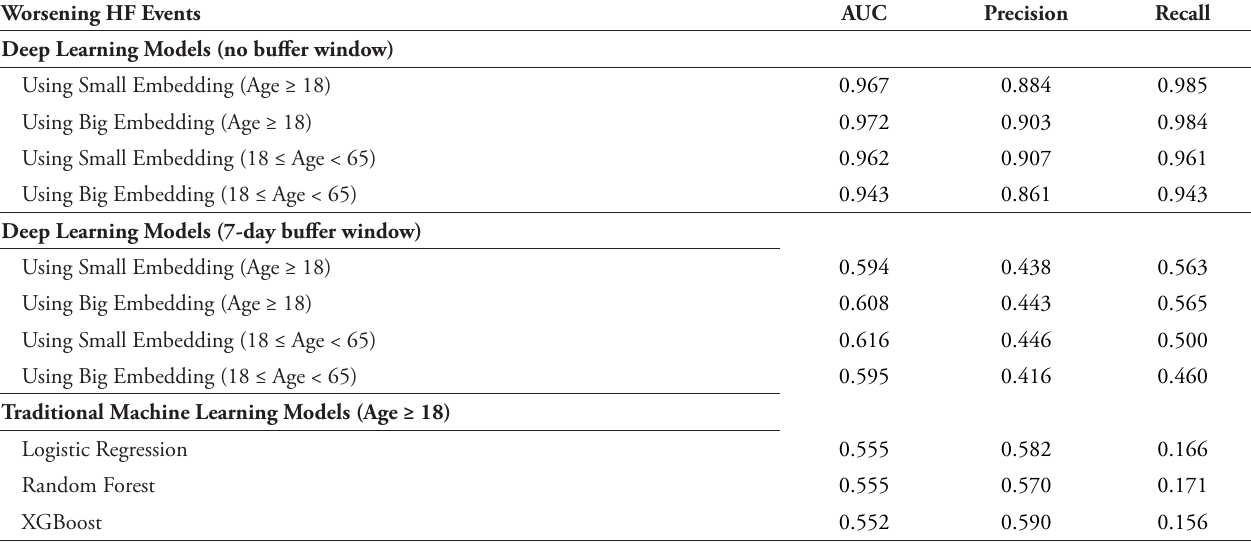
Abbreviations: AUC, area under the receiver operating characteristic curve; HF, heart failure.